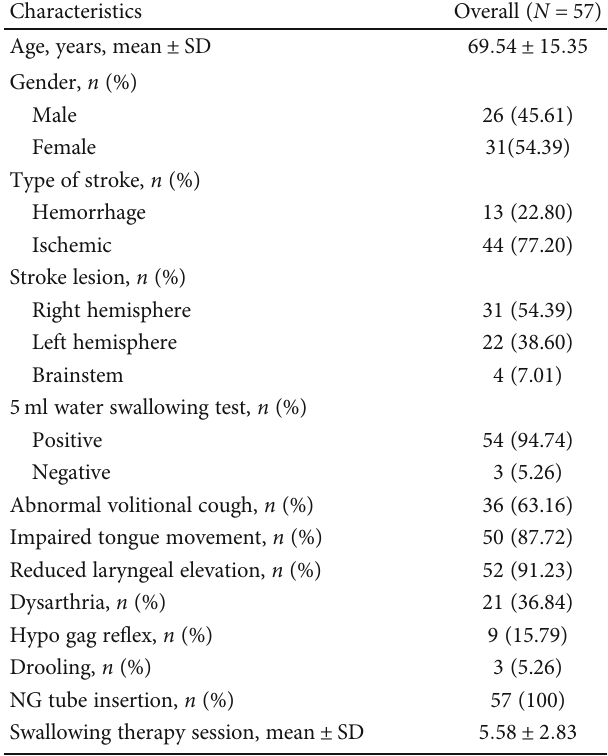
Table 1: Demographic and clinical characteristics of the patients.